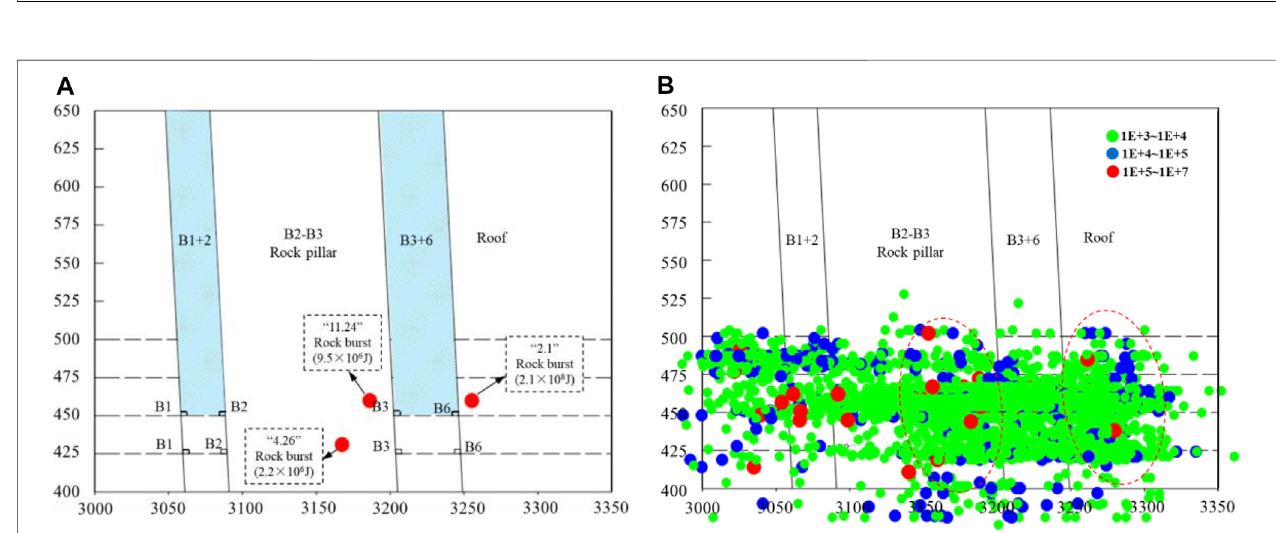
FIGURE 2 | Microseismic events distribution characteristics of rock bursts. (A) Elevation view of the rock burst distribution; (B) Spatial distribution of microseismic events with energy in the range of 10 3 – 10 7 J.